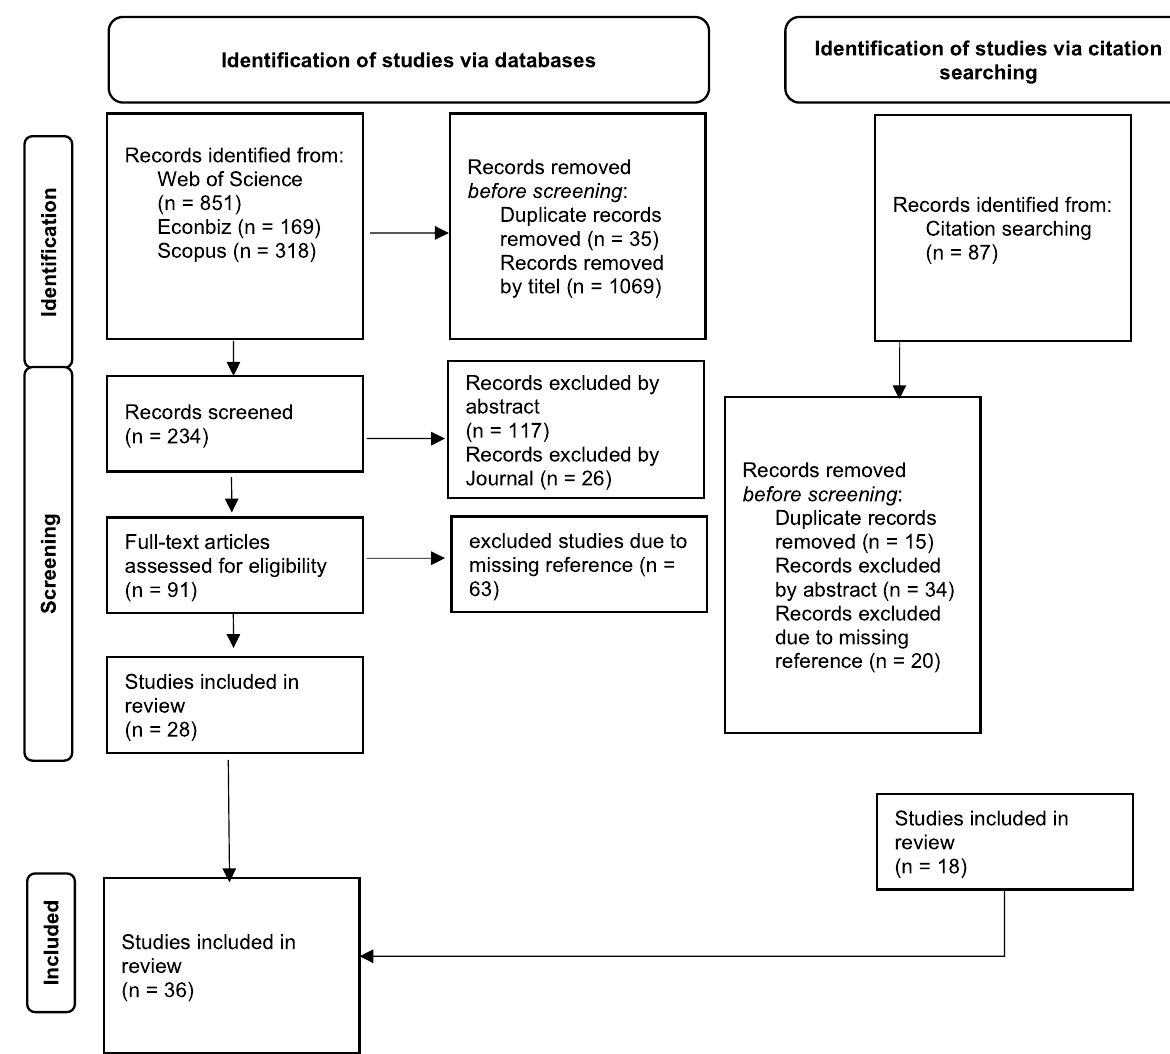
Fig. 2 PRISMA flow diagram (Page et al.,